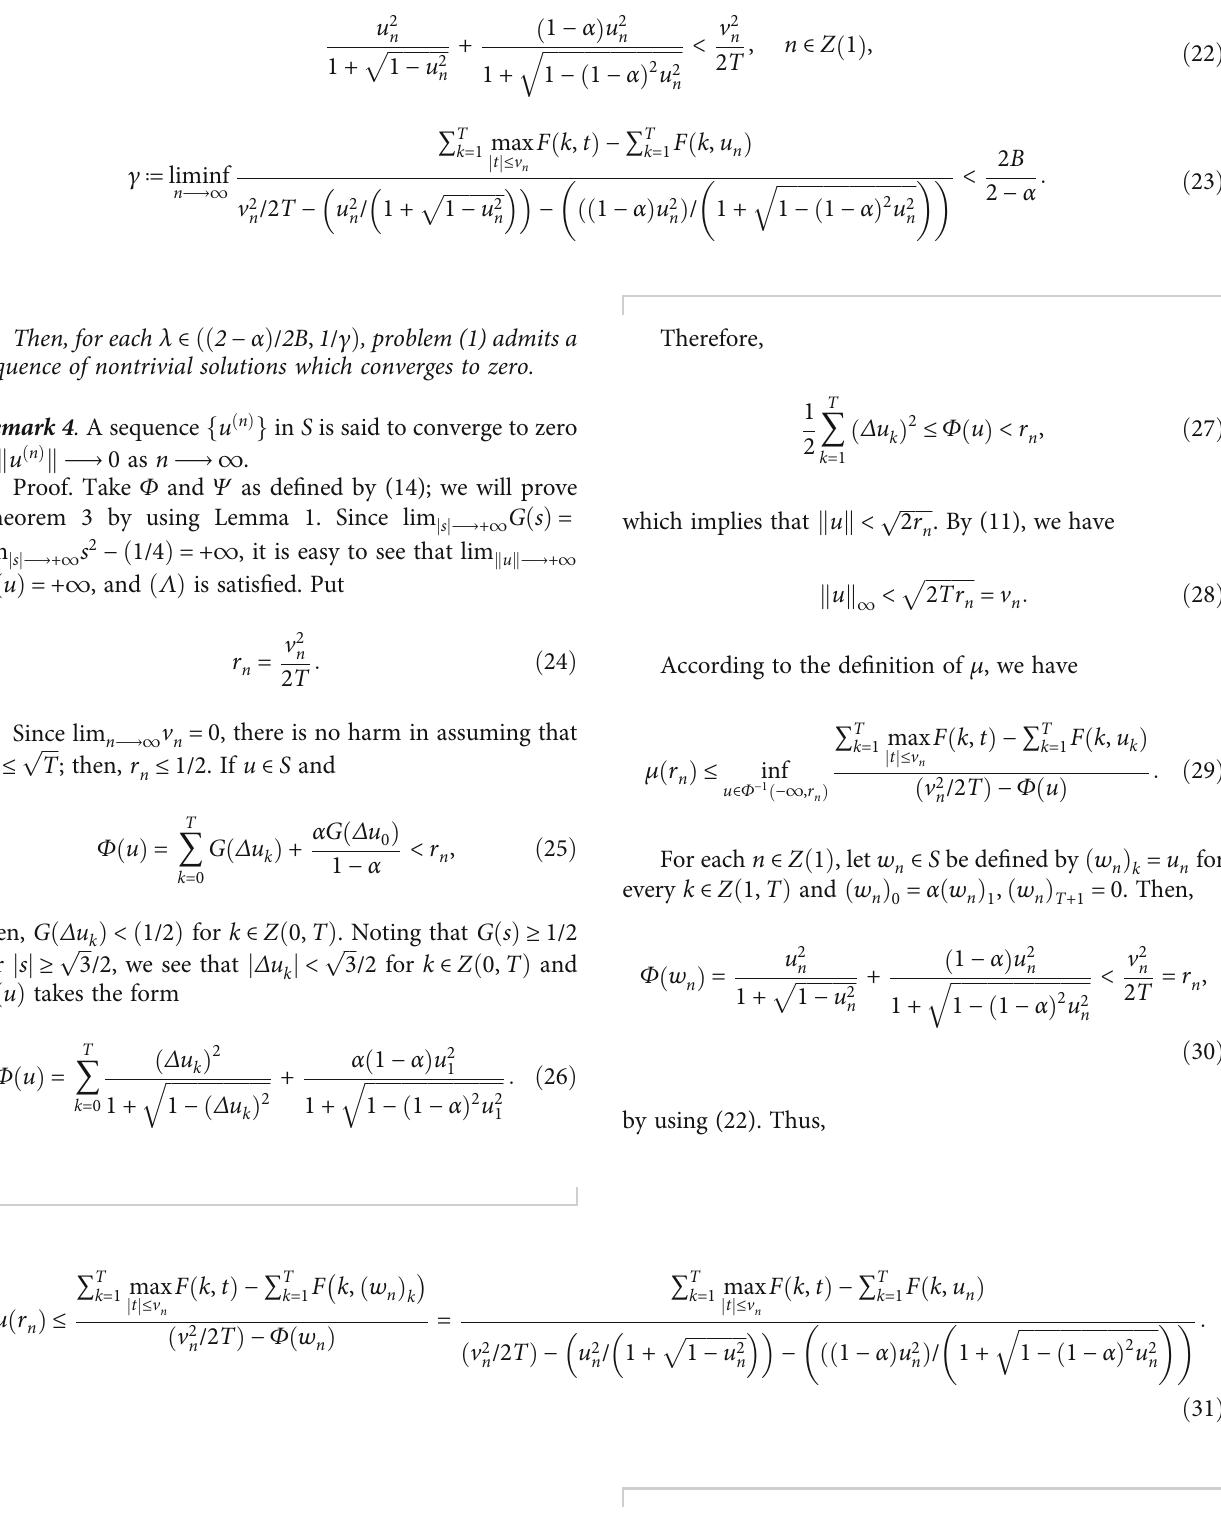
ffiffiffiffiffiffiffiffiffiffiffiffiffiffiffiffiffiffiffiffiffiffiffiffiffiffiffi